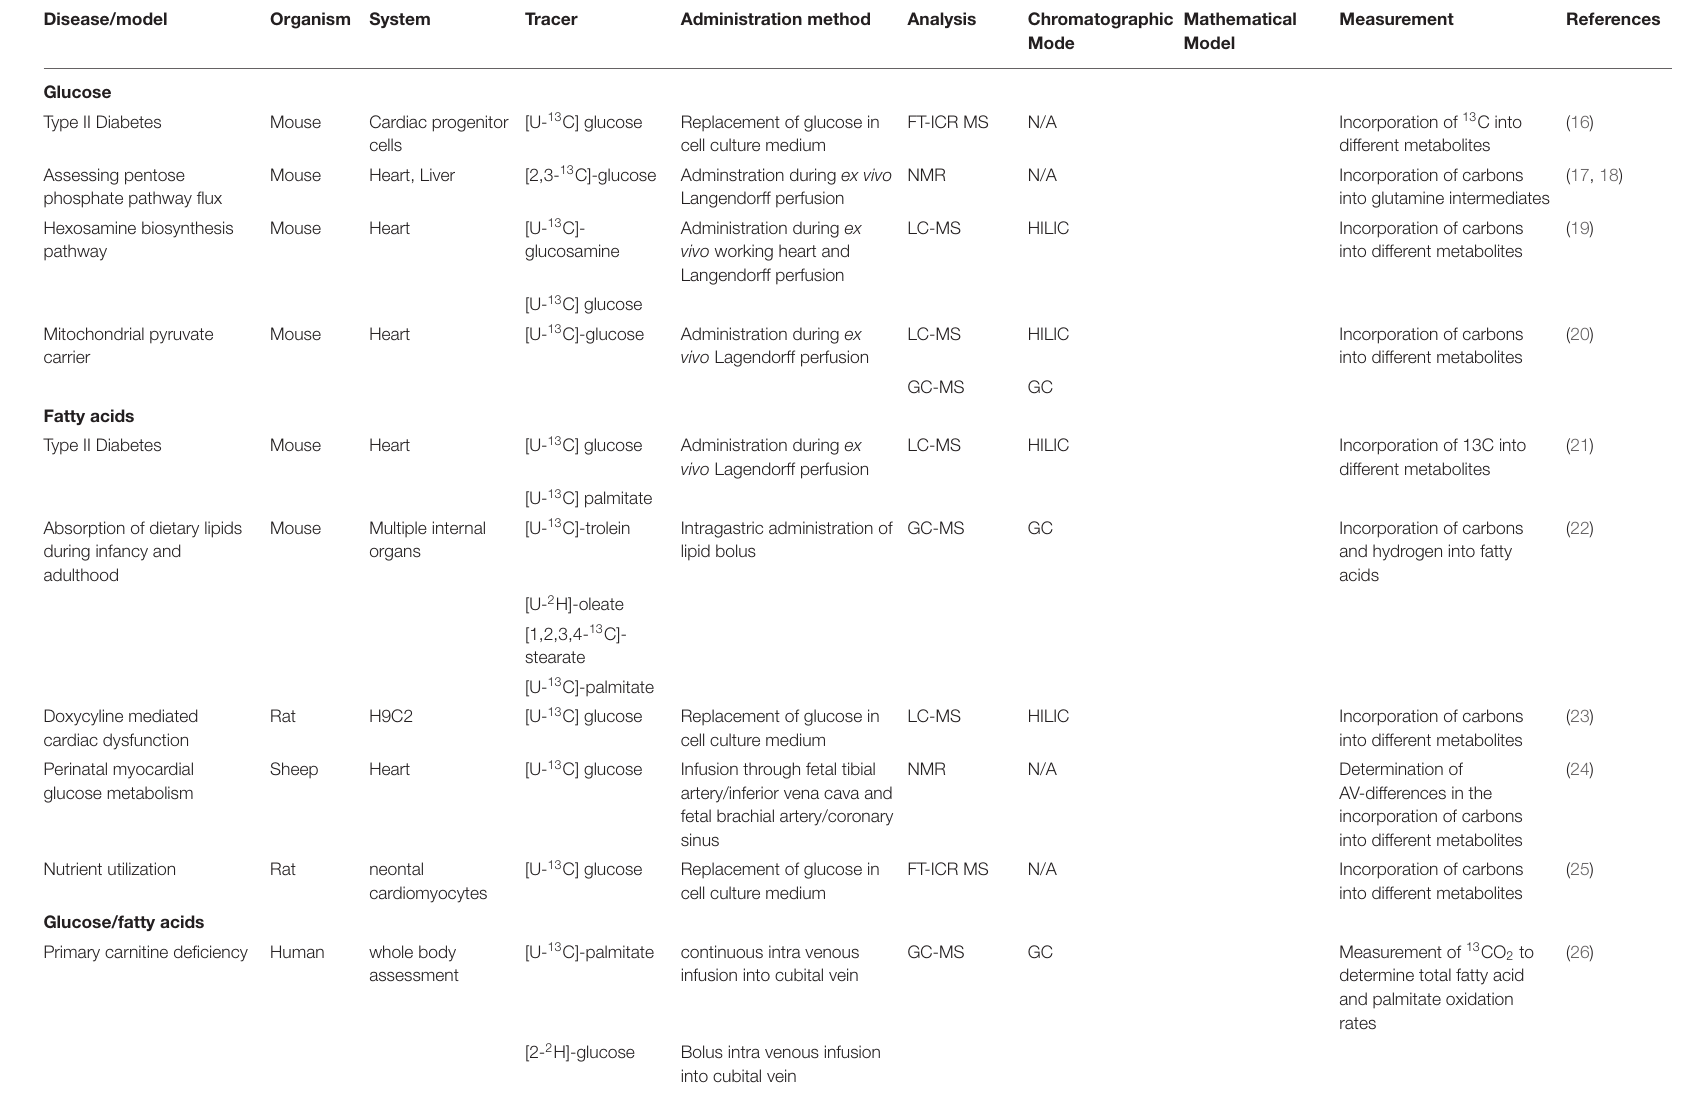
TABLE 1 | Overview of recent in vivo and ex vivo stable-isotope tracer studies in cardiovascular research, including administration methods, analytical platform, and chromatographic